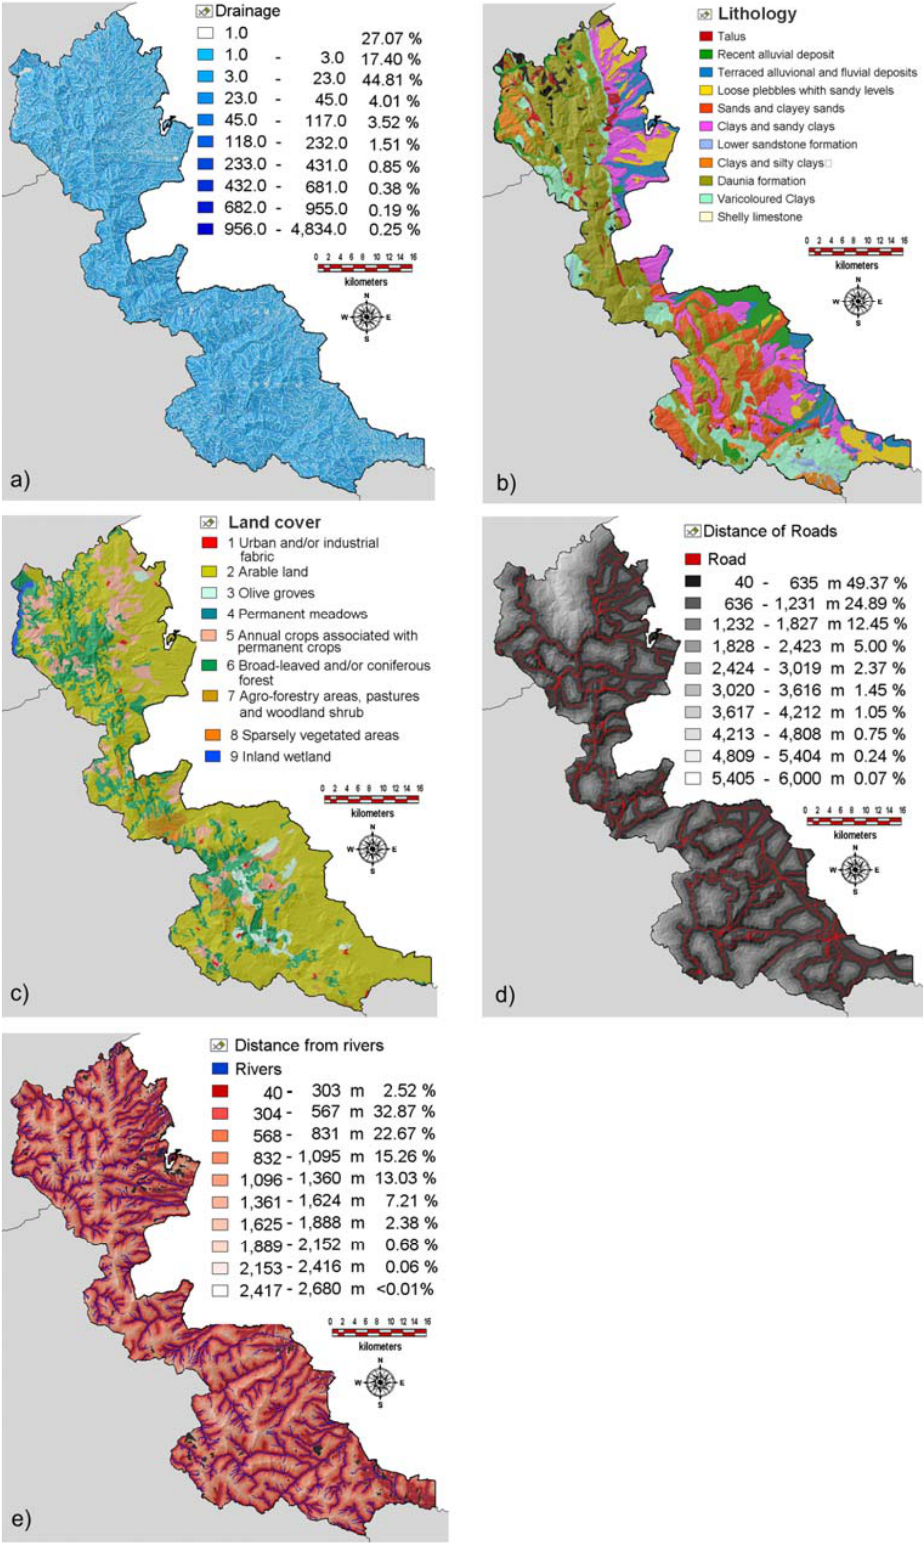
Fig. 5. Maps showing non-morphometric factors above discussed: (a) drained basin; (b) lithology; (c) land cover; (d) distance from roads, Figure 5. Maps showing non-morphometric factors above discussed: a) drained basin; b) 2 and (e) distance from lithology; c) land cover; d) distance from roads and e) distance from rivers. 3